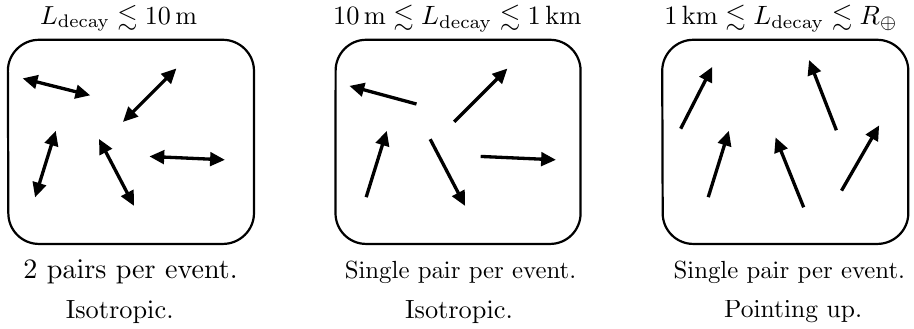
Figure 5 . A schematic illustration of the expected signals for various decay lengths of the media- tor V . In the case of (cid:9) 0 ! 2 V decay, each black arrow represents a pair of SM particles with a total energy of m = 2, an invariant mass of m V , and a total momentum pointing in the arrow direction. (cid:9) 0 A double arrow represents two such pairs